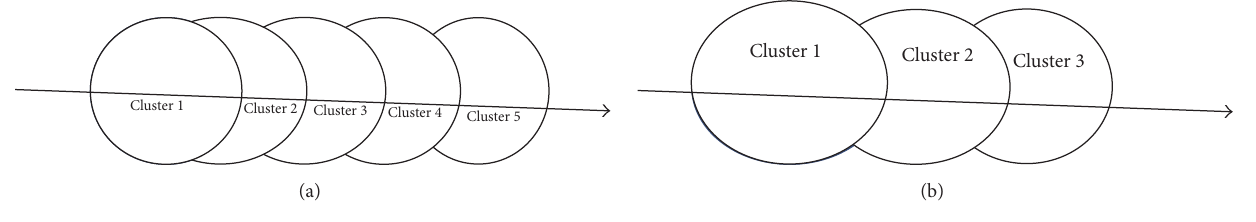
Figure 6: Overlapping of the